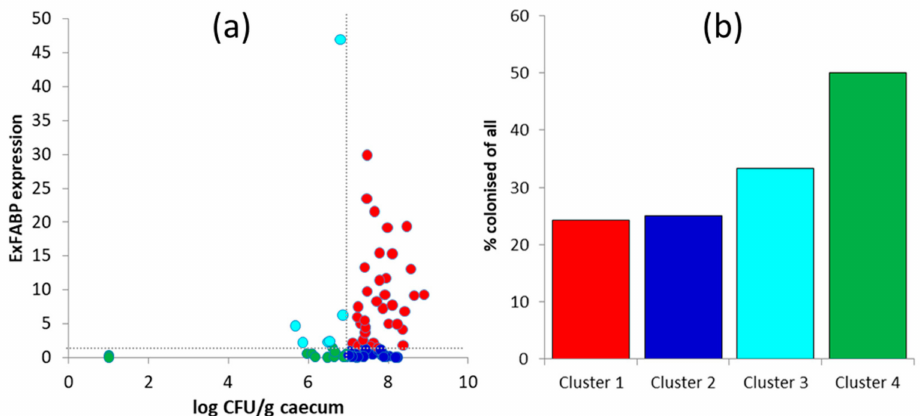
Figure 3. Salmonella counts and chicken inflammatory response. ( a ) Each dot represents a group of chickens inoculated with a particular anaerobe whose position is defined by average S. Enteritidis counts (log 10 CFU / g) and inflammatory response determined by ExFABP expression. Cluster 1 (red dots) is formed by the chickens that were inoculated with gut anaerobes that did not protect them against S. Enteritidis challenge (high S. Enteritidis count and high ExFABP expression). Cluster 2 (dark blue dots) comprised chicks that were inoculated with gut anaerobes that did not protect them against S. Enteritidis colonisation, but decreased chicken inflammatory response. Chickens in cluster 3 (light blue dots) were inoculated with gut anaerobes, which protected them against S. Enteritidis colonisation, but did not decrease the chicken inflammatory response. Chickens in cluster 4 (green dots) were inoculated with gut anaerobes, which increased their resistance to S. Enteritidis colonisation without an excessive inflammatory response. Panel ( b ) represents the percentage of e ffi ciently colonised chicks out of all inoculated belonging to clusters 1–4 defined in panel ( a ). The same colour coding in panels ( a , b ) is